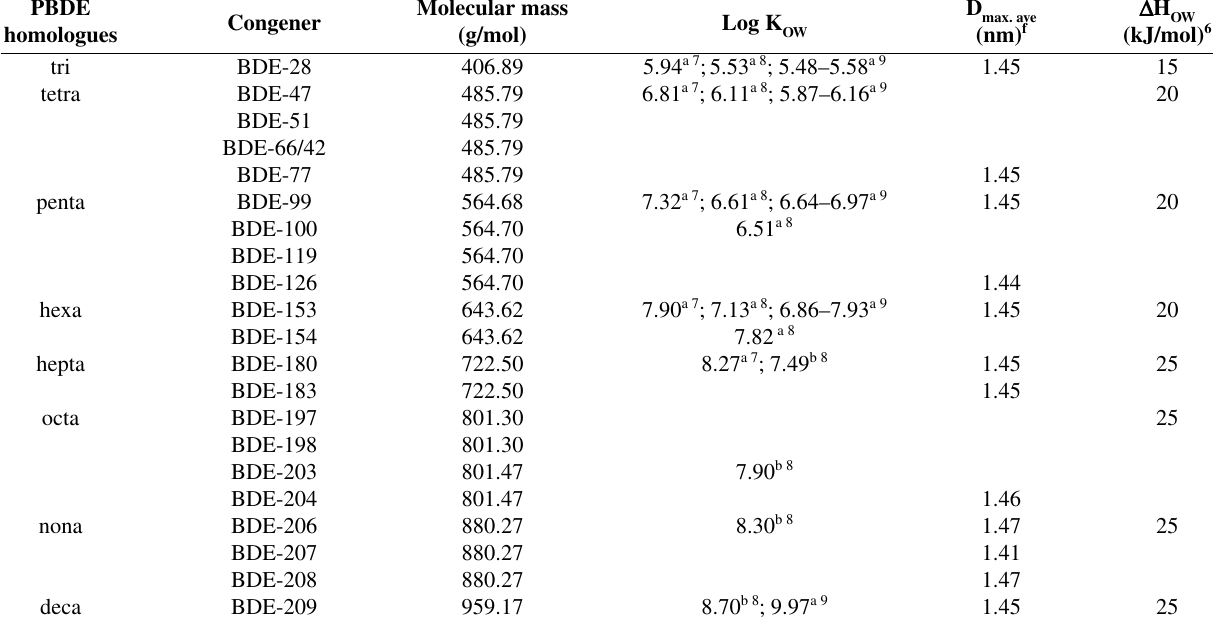
) molecular size (D. .-maximum average diame- OW max.ave ). OW